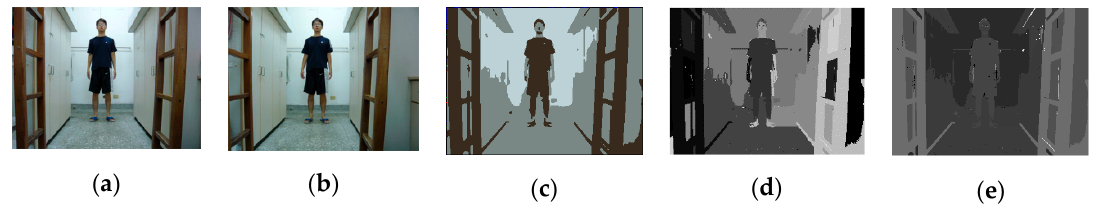
Figure 19. ( a ) Left image. ( b ) Right image. ( c ) Image after left-image object segmentation. ( d ) Image after left-image CCL processing. ( e ) Image after stereo matching.